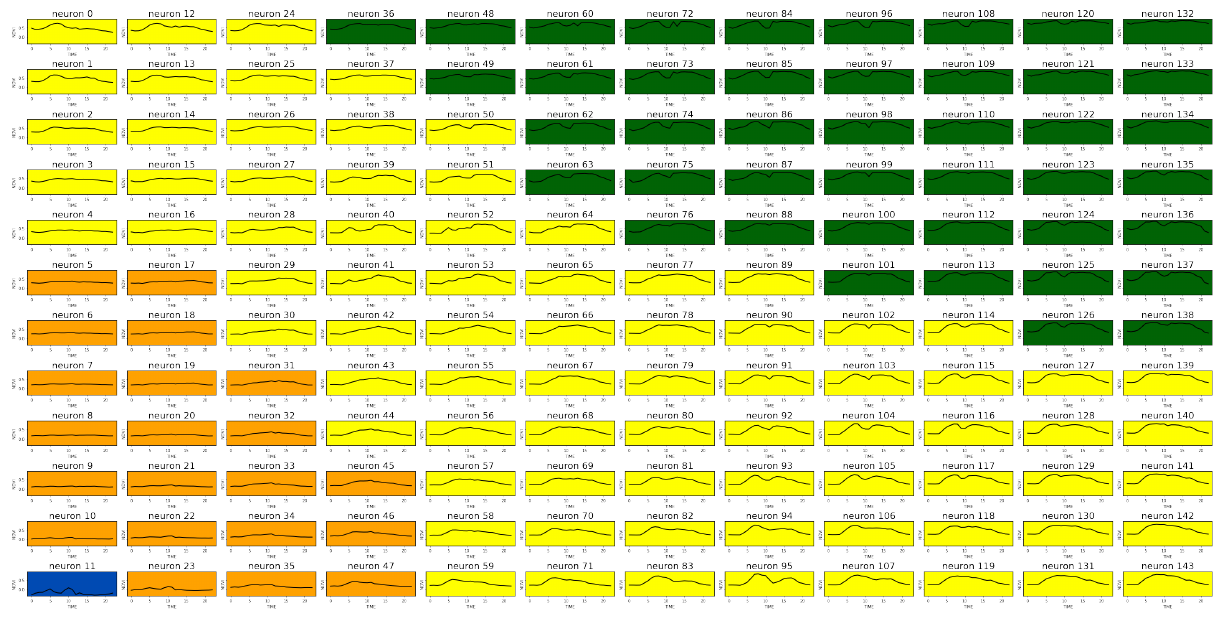
Figure 8. NDVI Codebooks vector of